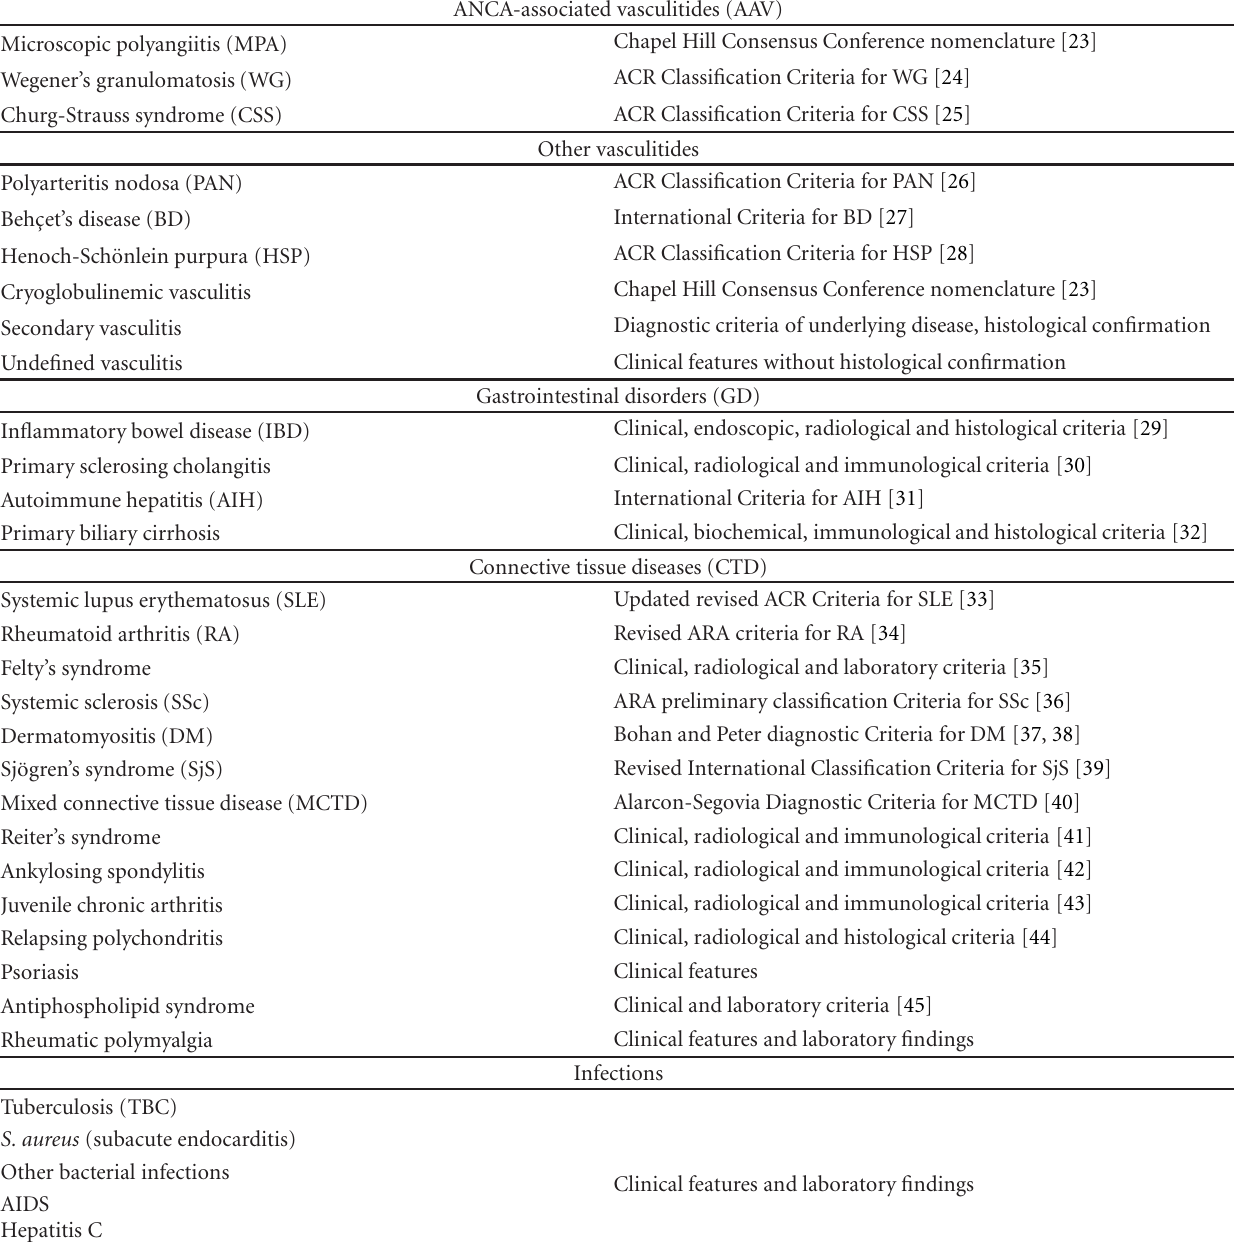
Table 1: Diseases and diagnostic